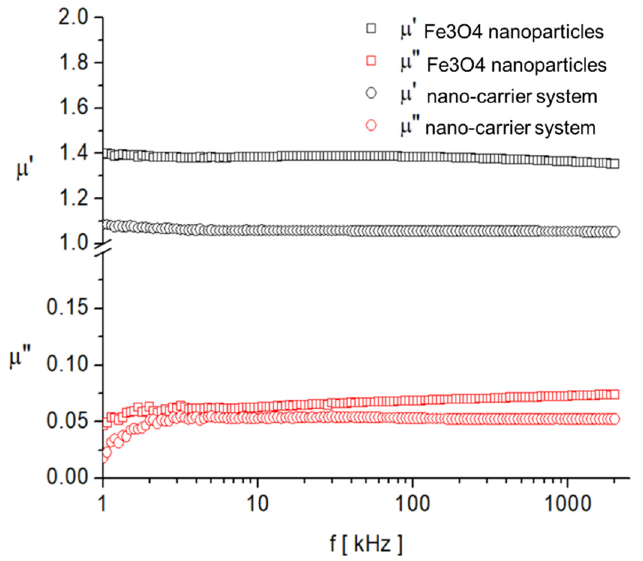
μ′ μ′′ , and imaginary, , components of the complex